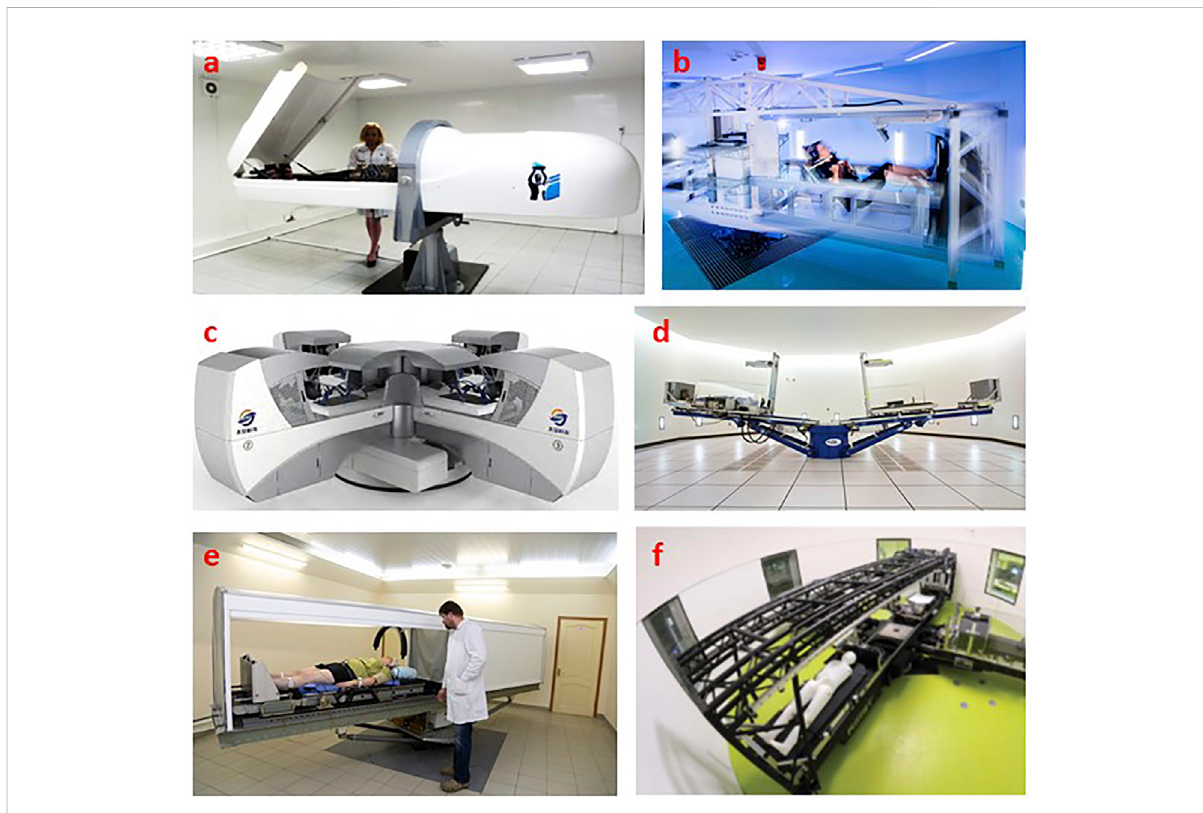
FIGURE 5 Some examples of short arm centrifuges used in treatment and in support of various space fl ight programs as countermeasure against microgravityrelatedpathologies. (A) One-persongravitytherapycentrifugeattheSamaraStateMedicalUniversity,Russia(OrlovandKoloteva,2017). (B) Upgraded SAHC from European Space Agency, ESA, at the Olympic Sport Centre Planica, Slovenia (image ESA & Jozef Stefan Institute Slovenia/ © K. Bidovec & A. Hodali č ). (C) Centrifuge at: Department of Health Technology, Space Institute of Southern China, Shenzhen, Guangdong, China. (D) NASAshortradiuscentrifuge currentlybeingre-installedatTexasA&MUniversity,UnitedStates(Aryaetal.,2007). (E) Shortarmcentrifuge at the Institute for Biomedical Problems, IMBP, Moscow, Russia. (F) Human Centrifuge at the:envihab center of the German space agency, DLR near Cologne, Germany (Frett et al.,